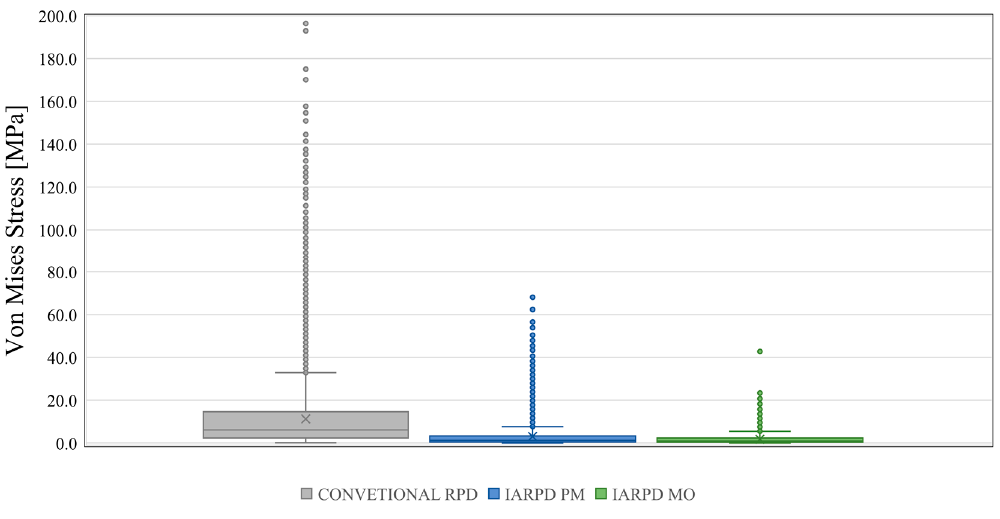
Figure 7. Boxplot of the von Mises stress values within the framework of each model. Lines inside the box mark the median value. Table 7. Mean differences in the von Mises stress of the chromium-cobalt framework between pairs of models. Statistical analysis with two sample t -tests, assuming equal variances and Bonferroni correction. 95% CI- 5% confidence interval for the